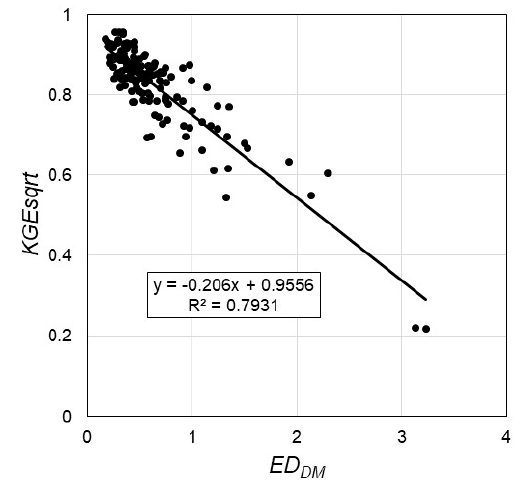
Figure 9. Scatterplot of 𝐸𝐷 (cid:3005)(cid:3014) vs. 𝐾𝐺𝐸 (cid:3046)(cid:3044)(cid:3045)(cid:3047) .